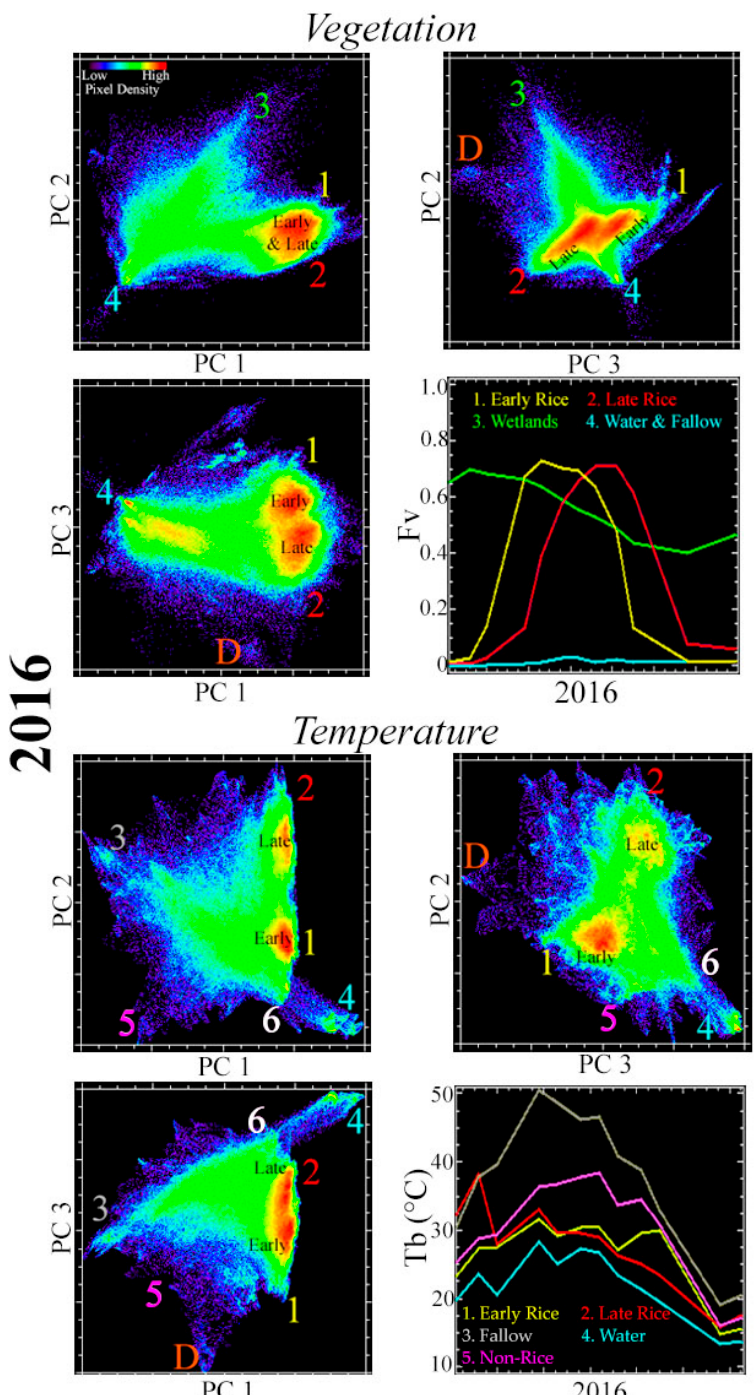
( a ) Figure 5. F v vs. LST 2016 temporal feature space (TFS) comparison. Each TFS highlights different aspects of the biogeophysical system. F v discriminates between early and late cropping, but cannot distinguish rice from other crops with similar timing. LST clearly distinguishes rice from other crops, but misses the late season variability captured by F v . These differences are reflected in EMs. F v EMs correspond to Early Rice (1), Late Rice (2), Wetlands (3) and Water & Fallow (4). EMs of the LST space include Early and Late Rice (3 & 2) and also differentiate between water (4) and fallow (1). Non-rice agriculture (5) and wetlands (6) are distinct in LST but not F v . Double cropping (D, Orange, EMs not shown) is also obvious with LST. Overall, the LST TFS is more complex and clustered than the F v